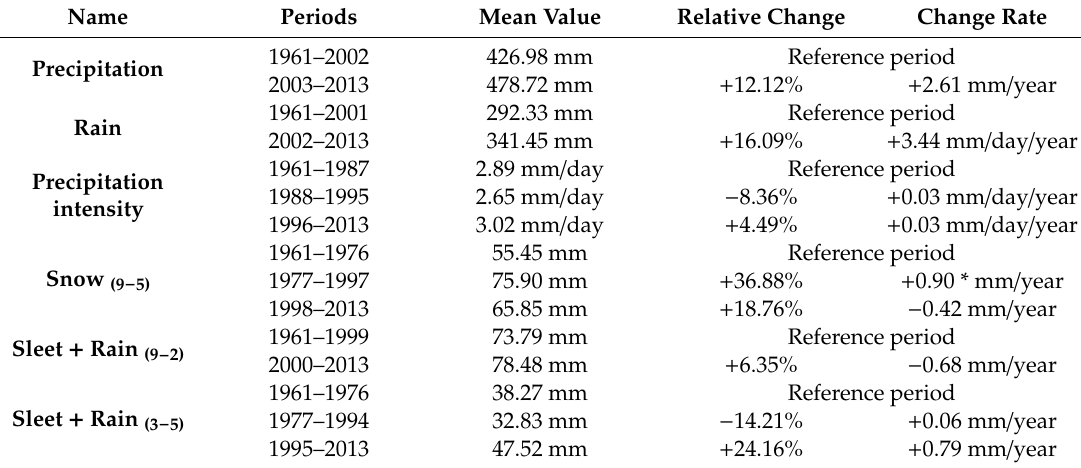
Figure 7. The change points of precipitation intensity (I), rain, and precipitation (P); and ( b ) cold season precipitation detected by moving t -test. Table 4. Precipitation changes in respective